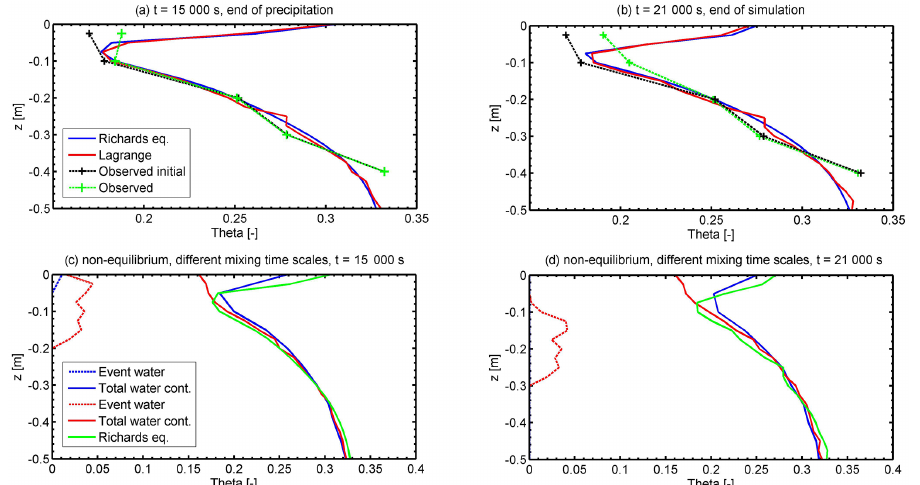
Figure 9. Soil moisture profiles simulated with the Richards equation (solid blue) and the particle model compared to observations in different depths at the end of the precipitation event (15000s) (a) and the end of simulation (21000s) (b) . Initial soil moisture observations are given as black crosses, and intermediate and final observations are given as green crosses. Panels (c) and (d) present fractions of event water (dashed lines) total water content (pre-event + mixed water) for simulations assuming non-equilibrium infiltration. Blue lines correspond to t mix = 4300s and red lines to t mix 4 = 7300s, and the solid green line shows the soil water content simulated with equilibrium